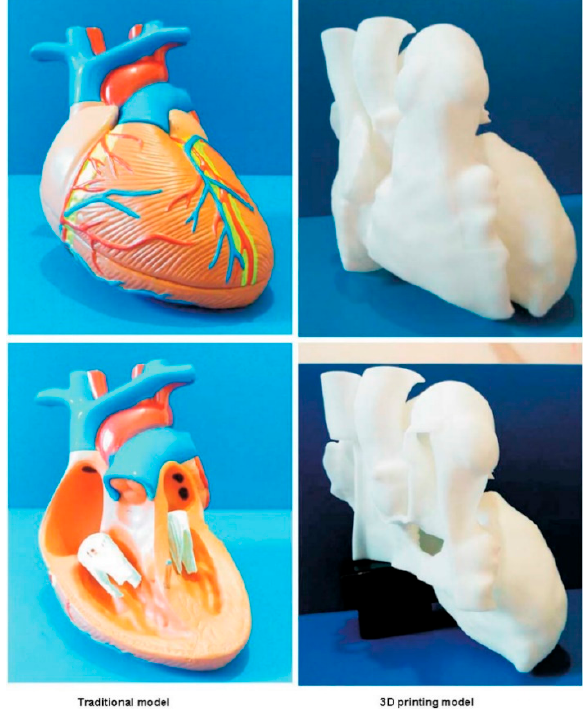
Figure 5. Traditional cardiac model (left) and 3D printed model (right) which are used in the study by Wang et al. for two di ff erent test groups to compare their role in facilitating medical education. Reprinted with permission under the open access from Wang et al.